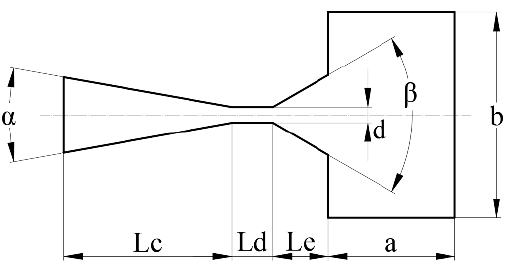
Figure 1. Schematic diagram of physical model.